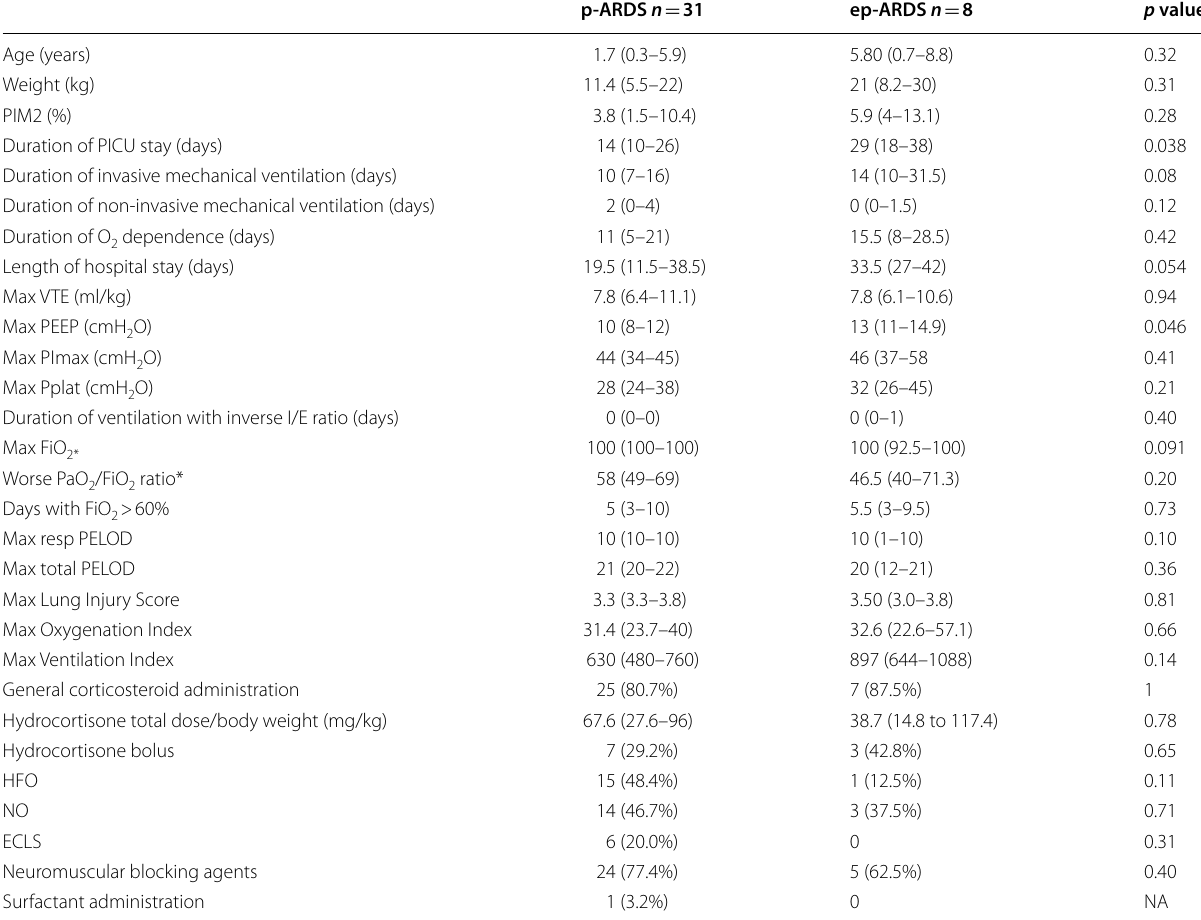
Table 2 Characteristics of the 39 children during their PICU stay by type of